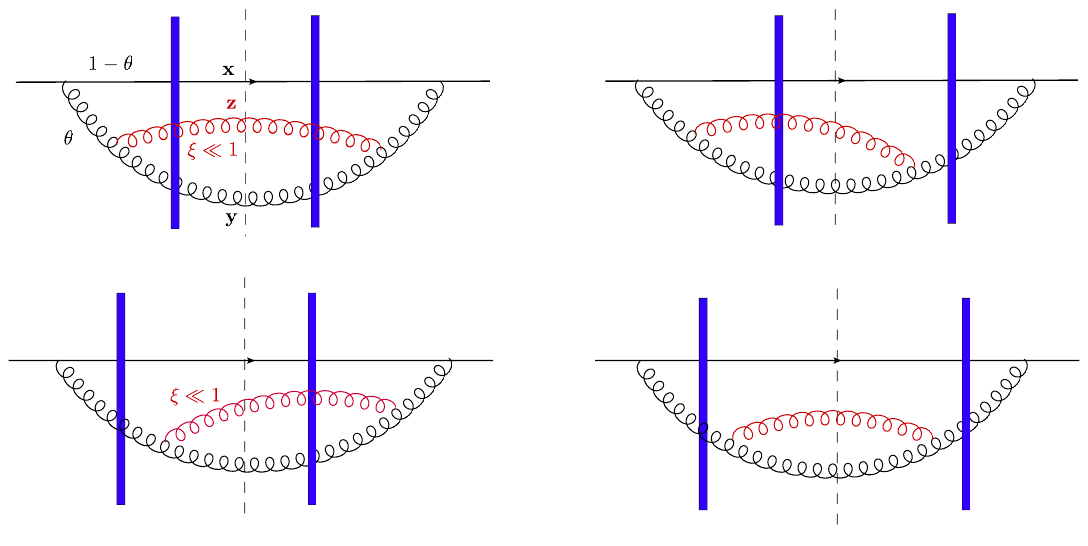
Figure 16 . The four diagrams contributing to the cross-section (3.46) in the eikonal limit ξ → 0 for one of the two emitted gluons (the one shown in